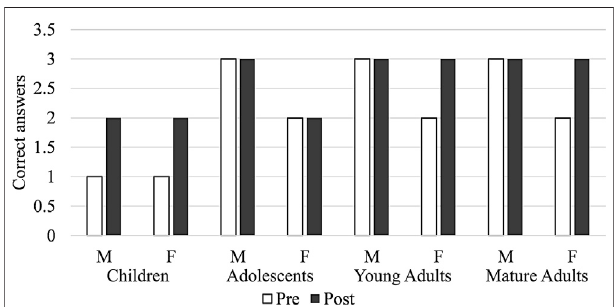
FIGURE 2 | Medians of correct answer before (pre) and after (post) visiting T ū hura for male (M) and female (F) visitors: male children ( n (cid:1) 56), female children ( n (cid:1) 55), male adolescents ( n (cid:1) 21), female adolescents ( n (cid:1) 55), male young adults ( n (cid:1) 57), female young adults ( n (cid:1) 96), male mature adults ( n (cid:1) 50) and female mature adults ( n (cid:1) 57). Children comprised visitors from 8 to 12 years old, Adolescents from 13 to 18, Young Adults from 19 to 40 and Mature Adults from